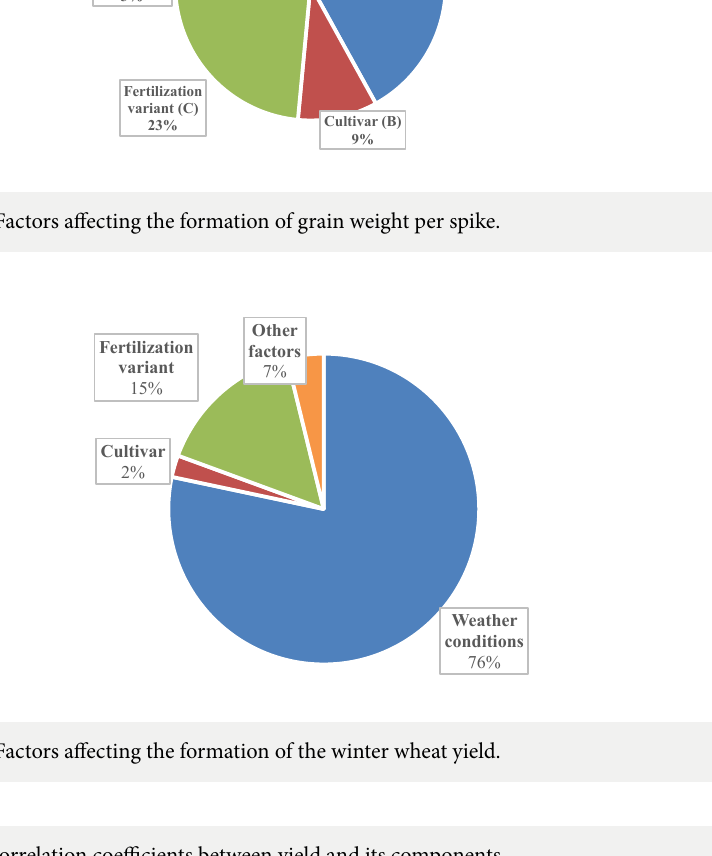
Table 5 Correlation coefficients between yield and its